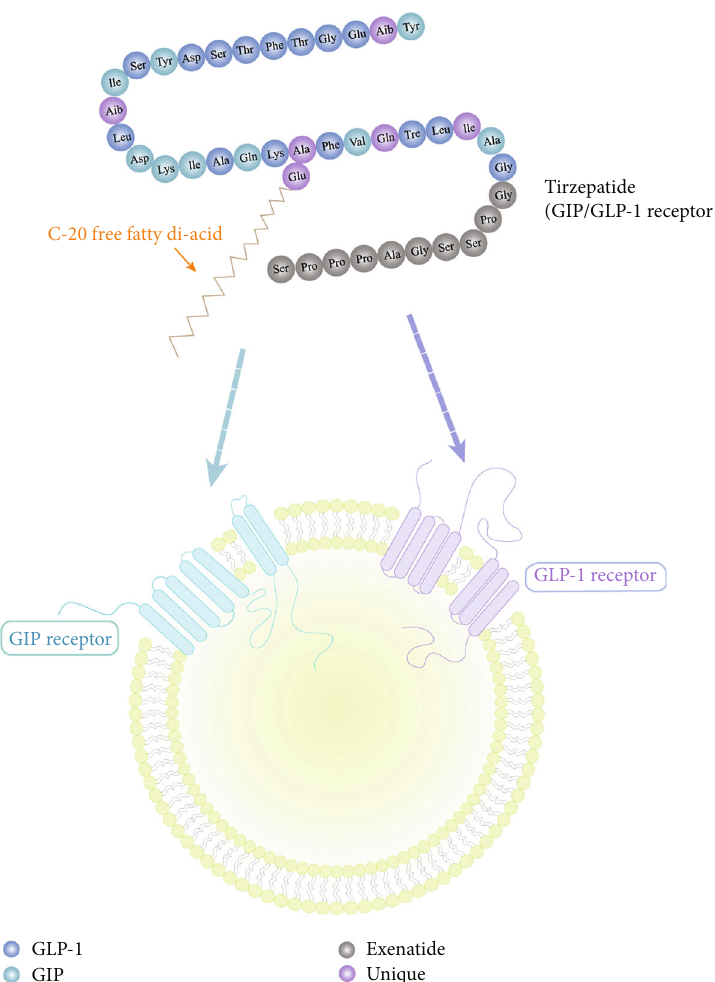
Figure 2: The structure of